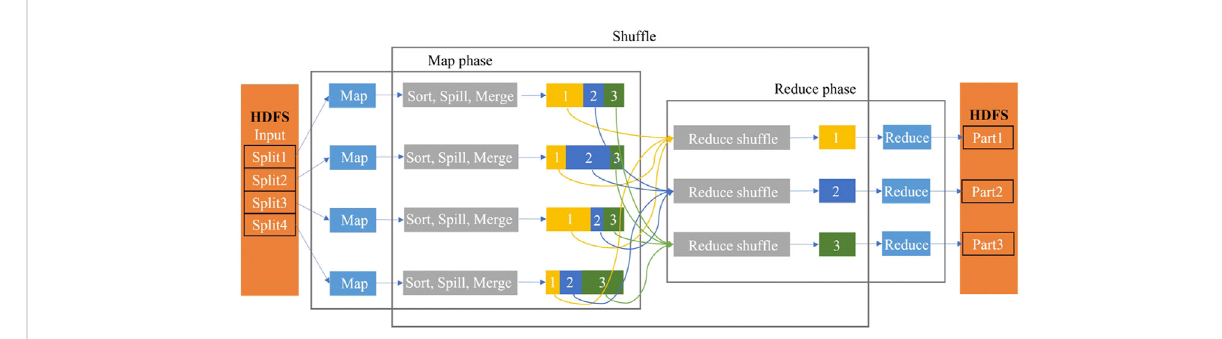
FIGURE 2 Data fl ow overview of the MapReduce model with four Map workers and three Reduce